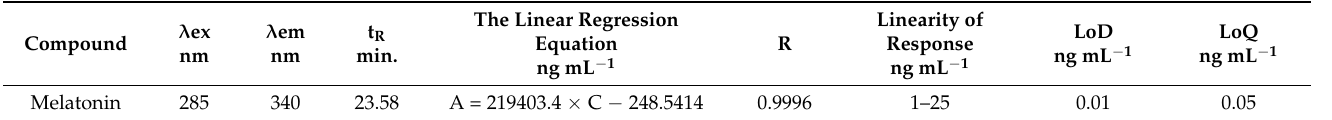
Table 1. Some performance characteristics of the HPLC-FL method used for melatonin analysis of wine samples.